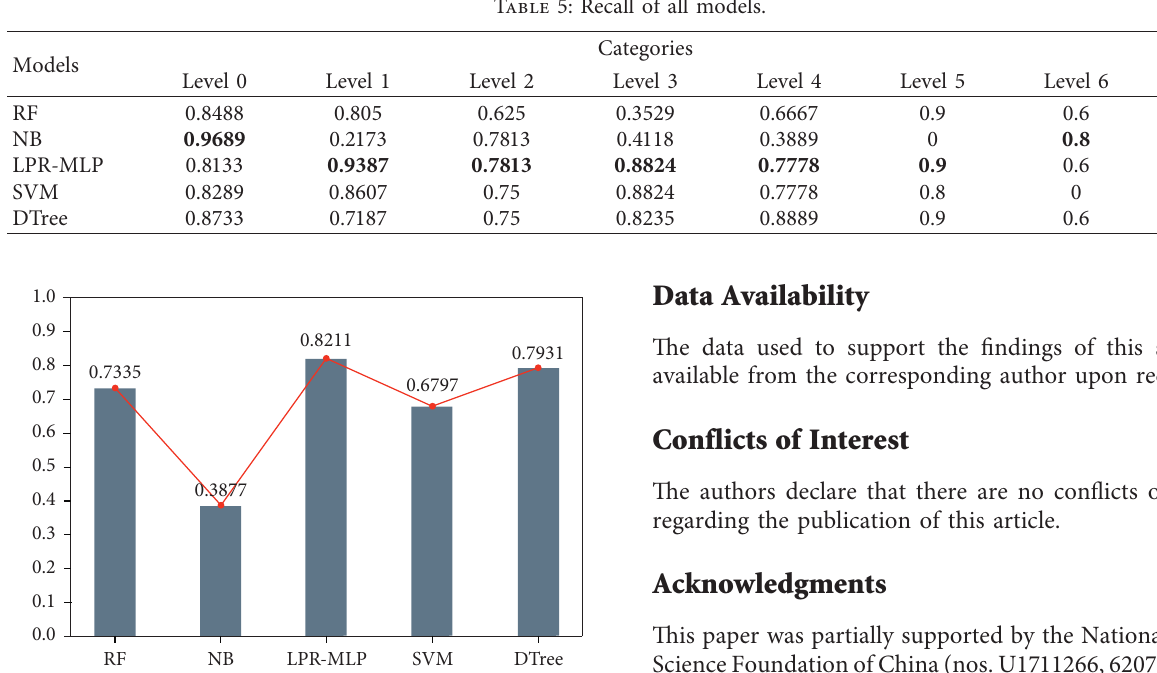
Figure 5: Macro F 1 value of the experimental